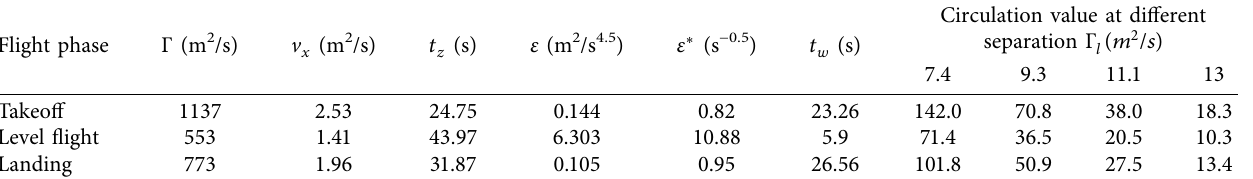
Table 2: A380 wake dissipation parameters.